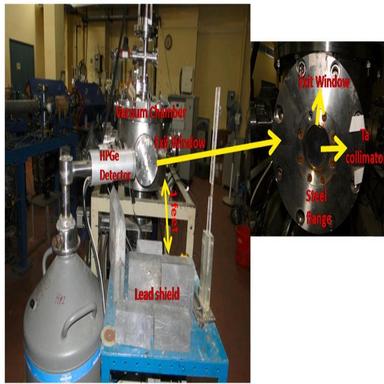
External (in-air) PIGE facility with gamma-ray detection system at FOTIA, BARC.